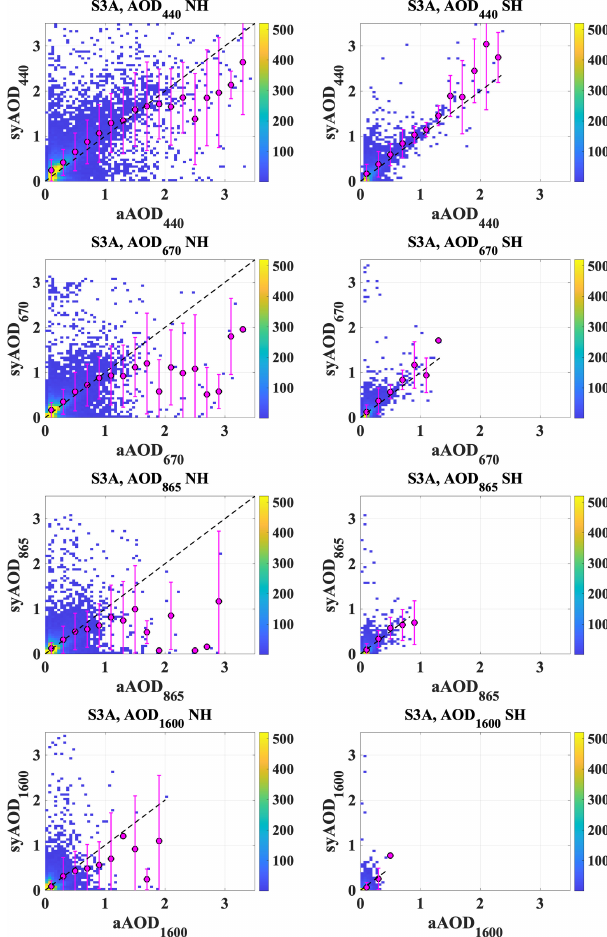
Figure 12. Scatter plots for SY_2 AOD 440 , AOD 670 , AOD 870 , and AOD 1600 (panels top down) for the NH and SH (left and right pan- els,